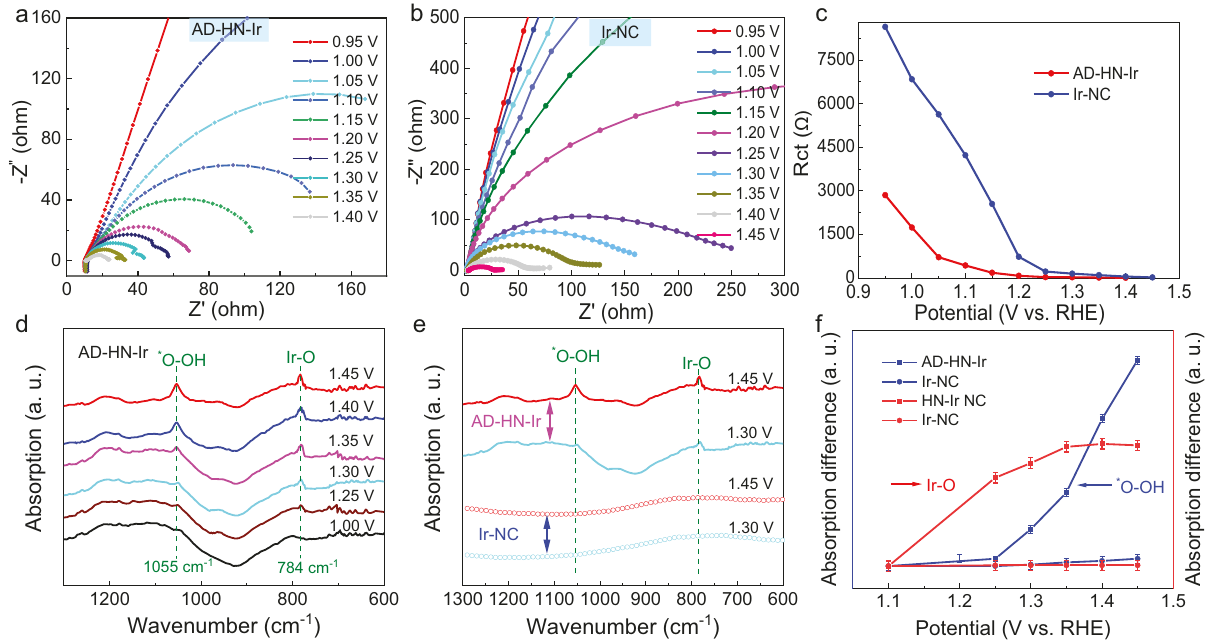
Fig. 4 In situ EIS and SRIR measurements. Nyquist plots for a AD – HN – Ir and b Ir – NC electrocatalysts at different applied potentials in 0.5 M H 2 SO 4 . c Response of the ion adsorption resistance ( R ct ) at different potentials for AD – HN – Ir and Ir – NC electrocatalysts. d In situ SRIR measurements in the range of 1300 – 600cm − 1 under various potentials for AD – HN – Ir electrocatalyst during the OER process. e In situ SRIR results in the range of 1300 – 600 cm − 1 at typical potentials of 1.30 and 1.45 V for AD – HN – Ir and Ir – NC electrocatalysts. f Intensity difference of the infrared signals at 1055 and 784 cm − 1 versus potentials for AD – HN – Ir and Ir – NC electrocatalysts during the OER